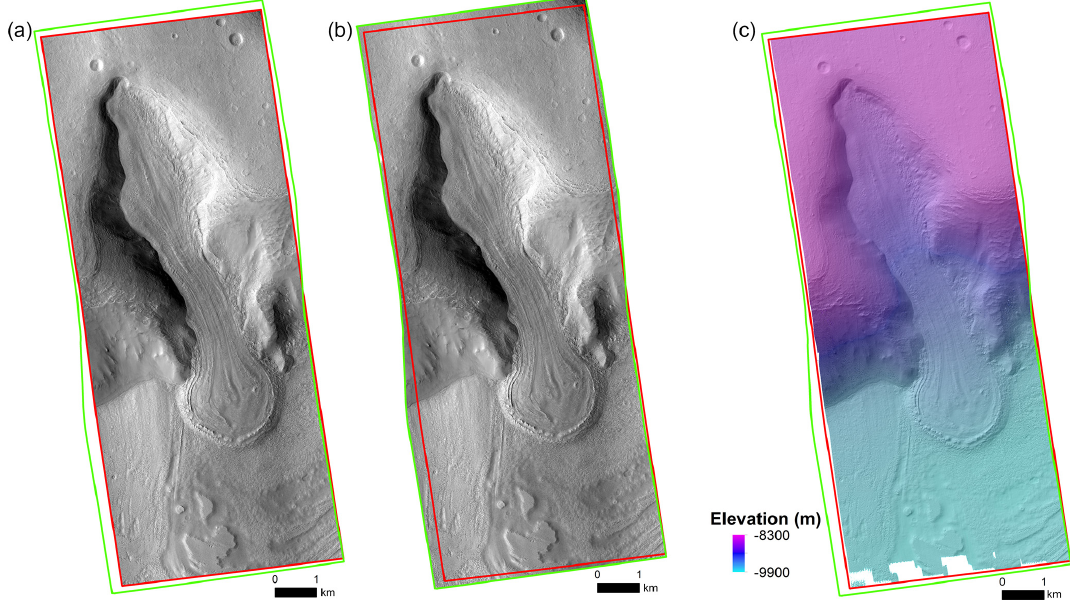
Figure 1. Inputs and outputs of the stereogrammetry process. Here, a left map-projected image ( a : HiRISE EDR: ESP_052535_2225) and right map-projected image ( b : HiRISE EDR: ESP_052324_2225) are passed to the ASP stereo programme. Stereo uses the camera information associated with the input images to assign 3-D coordinates to each cell. The output point cloud from this process can then be converted to a DEM at 1–2mpixel − 1 resolution ( c ), and hillshaded to aid interpretation. The glacier-like form visible here, has been a frequent target of HiRISE imagery, but 3-D models enable one to interrogate how this feature may flow downslope. This figure and all subsequent figures are orientated northwards unless it is indicated